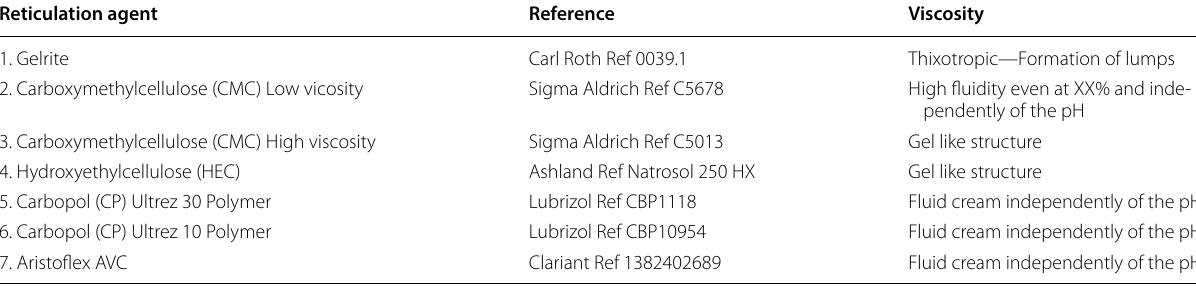
Table 2 Reticulation agents tested and apparent fluidity of the